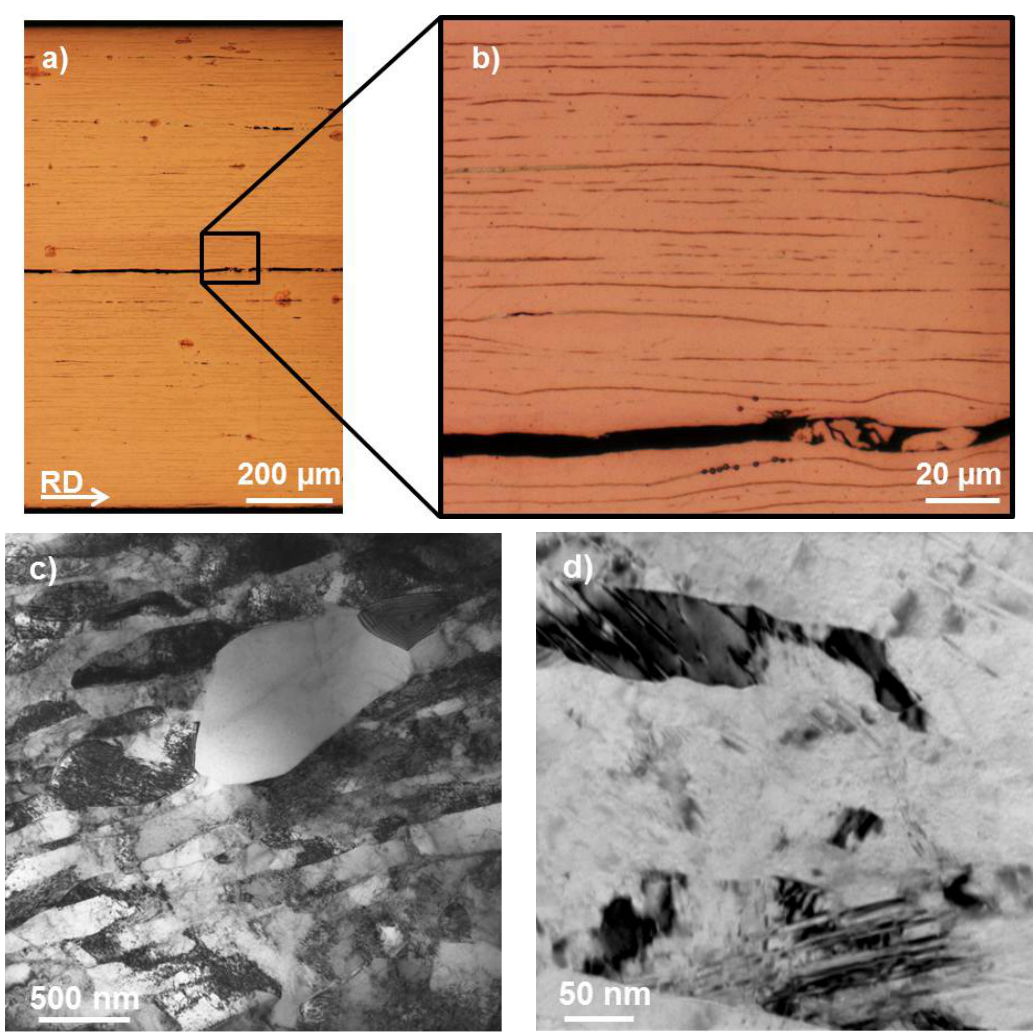
Figure 2. ( a ) Aluminum particle strengthened OFHC-Cu in optical microscope and ( b ) detail of the last bond plane. TEM microstructure of ( c ) OFHC-Cu after three ARB cycles and ( d ) OFHC-Cu alloyed with 3.8 vol.% aluminum after three ARB